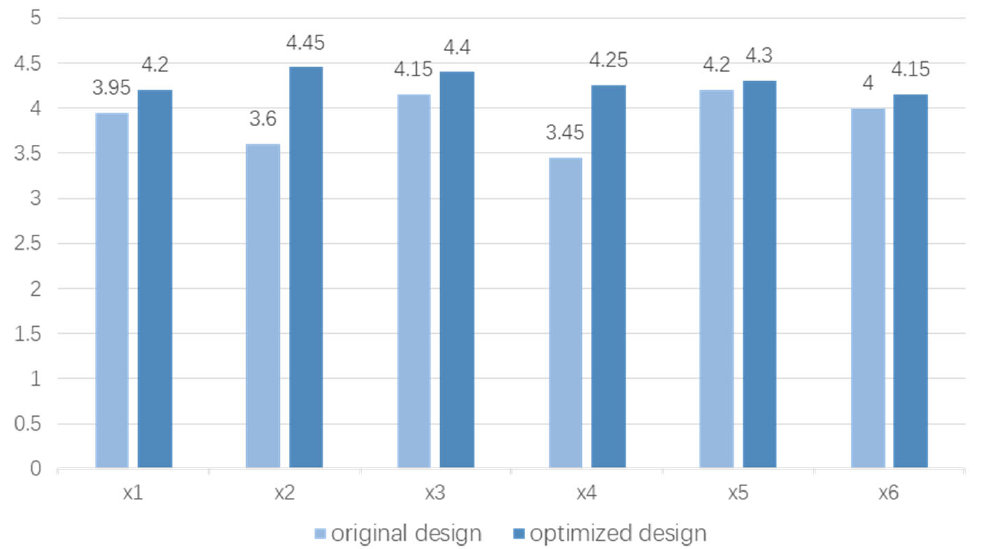
Figure 10. Comparison of user evaluations of coating design schemes.